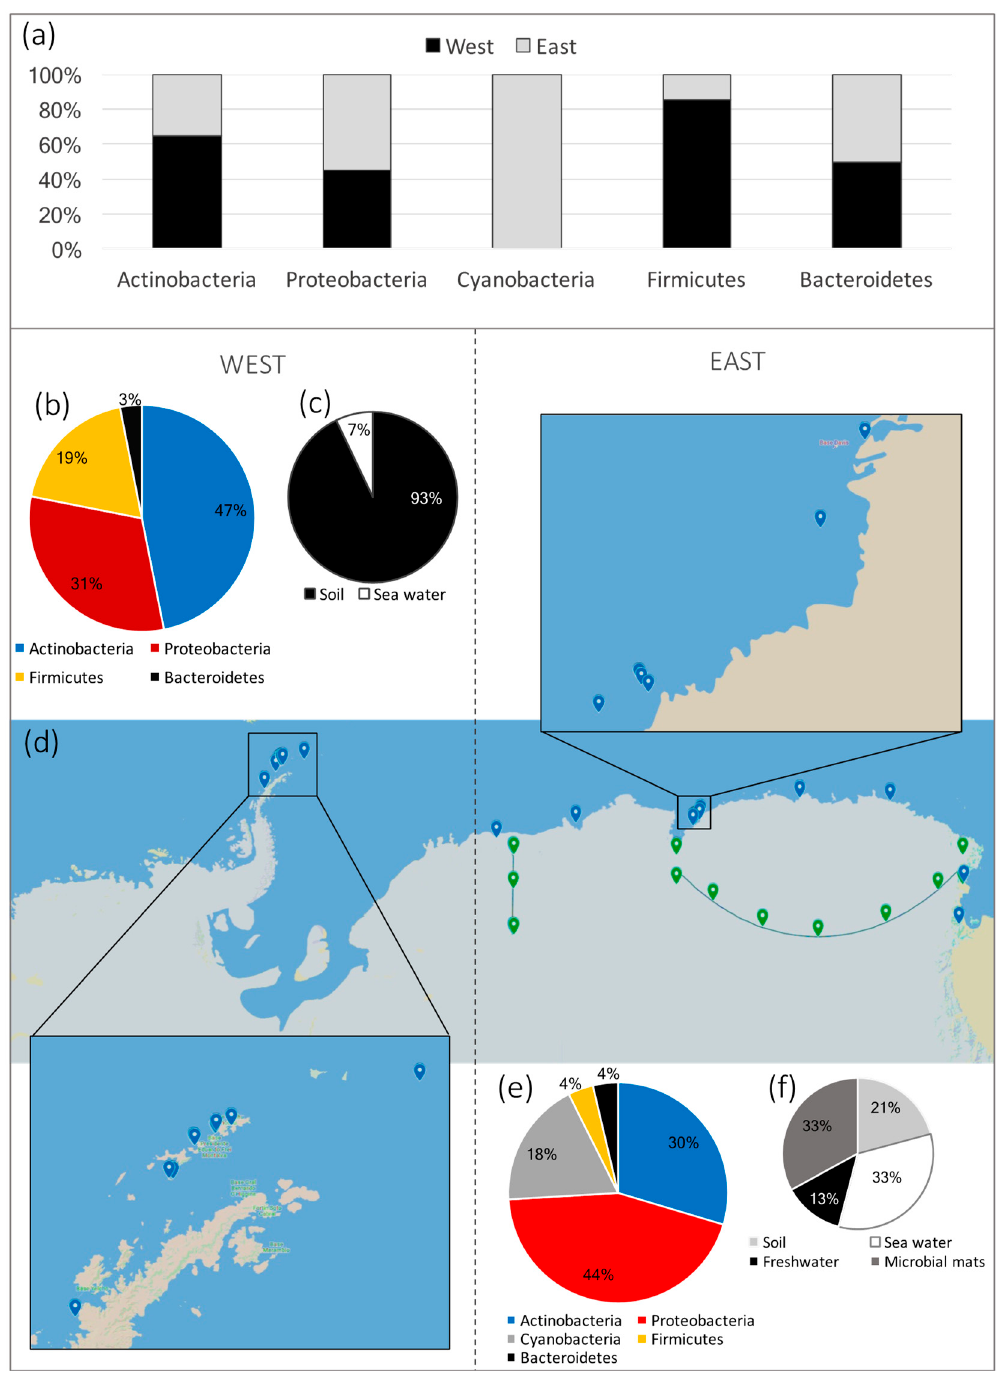
Figure 2. Reported diversity of Antarctic bacteria producing antimicrobial compounds and the geographical locations where diverse sample types were collected for isolation. Different phyla diversity has been reported for west and east Antarctic ( a ); each phylum has been reported with different frequency for the west side ( b ) compared to the east counterpart ( e ). Geographical locations where bacteria with antimicrobial activity have been isolated at each Antarctic side are shown, indicating that the west side has been less explored ( d ). Blue marks represent regions where punctual sampling was executed; green marks joined by a line illustrate two studies [14,17] where the complete area was sampled; the amplified squares show regions with multiple sampling sites. Active strains have been isolated utilizing different sample sources for west ( c ) and east ( f ) continent sides, including soil and seawater for both areas, and freshwater and microbial mats on the west side.